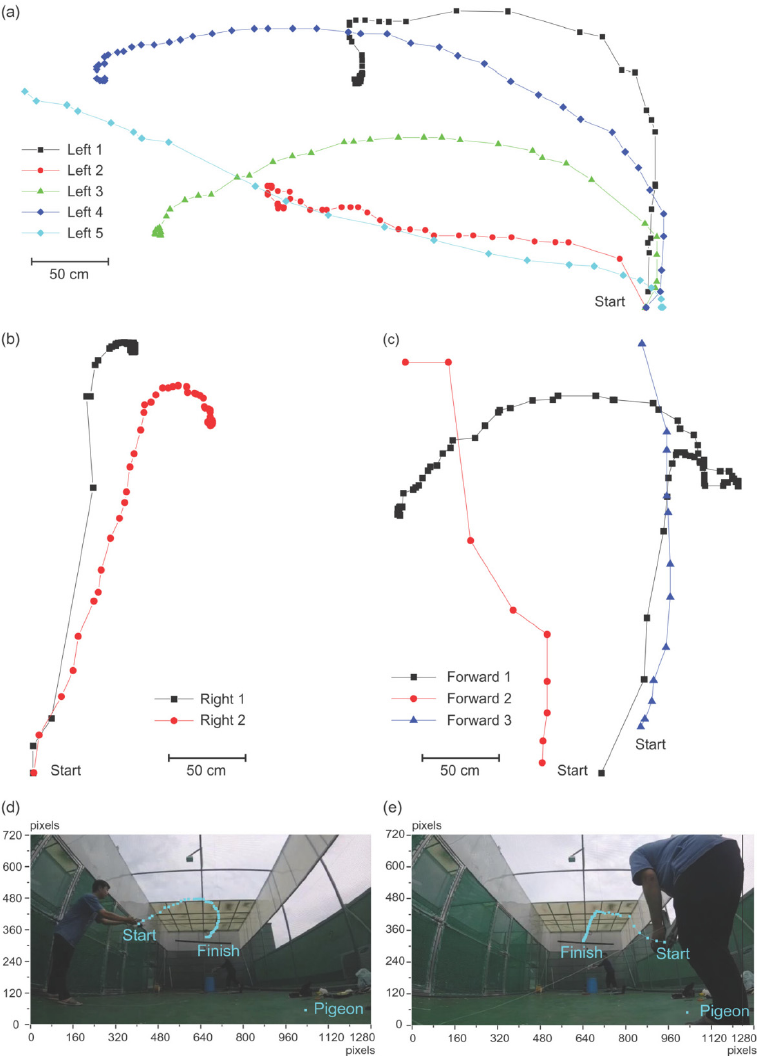
Figure 3. Sample trajectories of free flying pigeons without electrical brain stimulation. Indoor trajectories of a pigeon grouped as ( a ) leftward, ( b ) rightward, and ( c ) forward flight. In the aviary, when pigeons flown from the ( d ) left or ( e ) right, landed on a perch at the end of their flight regardless of the flying